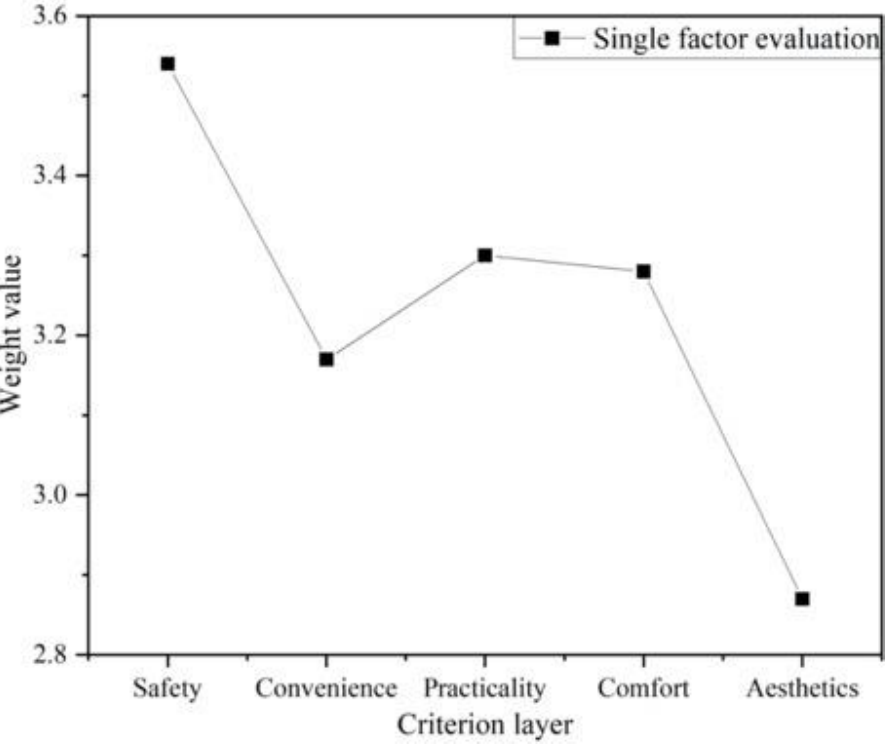
Figure 6. Evaluation results of the environmental criterion level of transfer spaces.